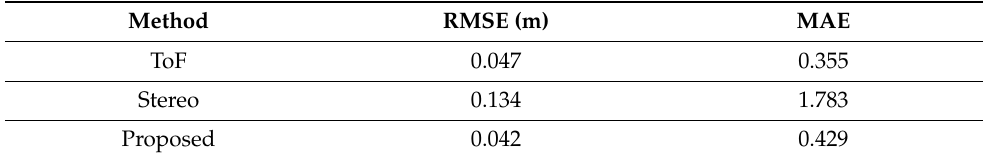
Table 1. Result of accuracy test by distance.